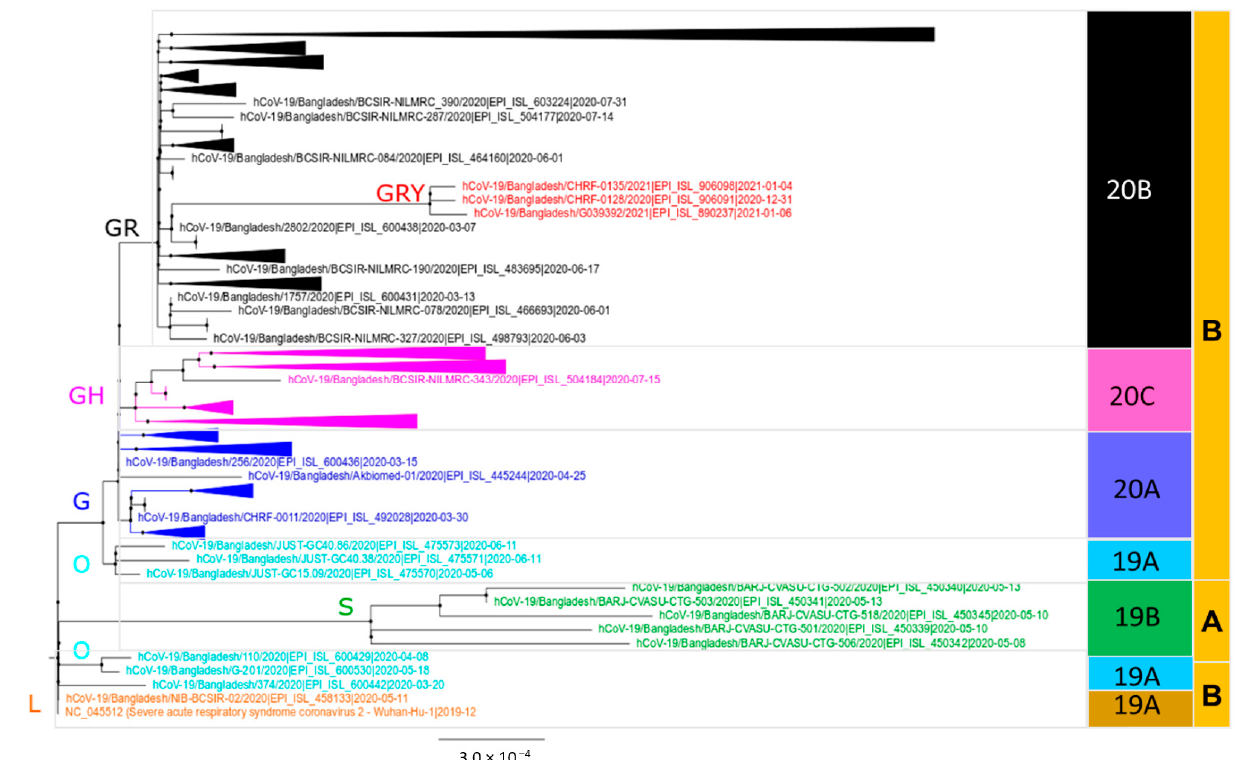
Figure 2. RAxML phylogenetic tree of 791 complete sequences of Bangladeshi SARS-CoV-2 showing the branch separating clades and lineages. The tree is rooted on Wuhan-Hu-1 (NC045512) reference strain. Seven different clades (GISAID) are highlighted as G = blue, GH = pink, GR = black, GRY = red, O = cyan, S = green, and L = orange. Five Nextstrain clades (20A, 20B, 20C, 19A, and 19B), as well as lineages A and B, are outlined in the left two-color columns. Compressed sub-tree indicates taxon names from similar clade branch/clusters. The full tree is available as Supplementary Figure S1.